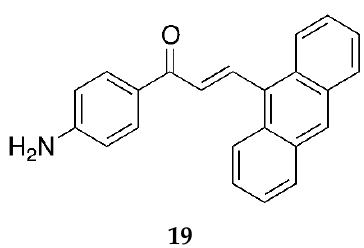
Figure 16. Chemical structures of the 4-aminochalcone derivate with an anthracene ring.